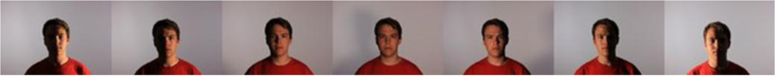
Photos of seven different lighting angles were taken for every position.